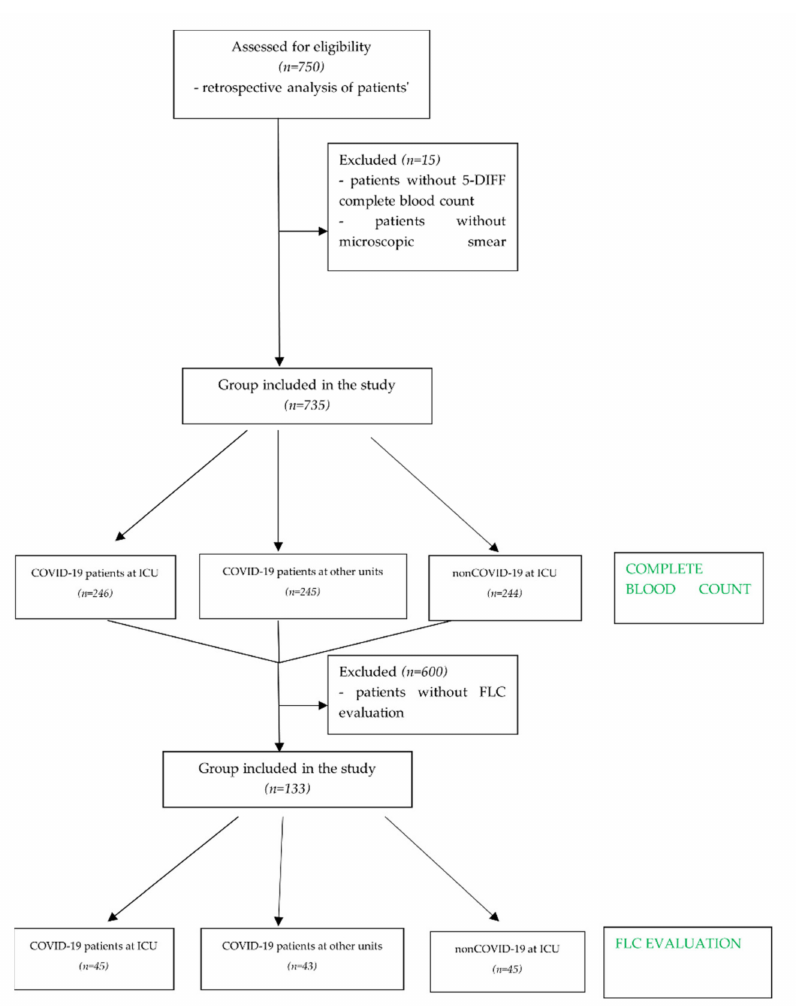
Figure 1. Enrollment scheme—study group